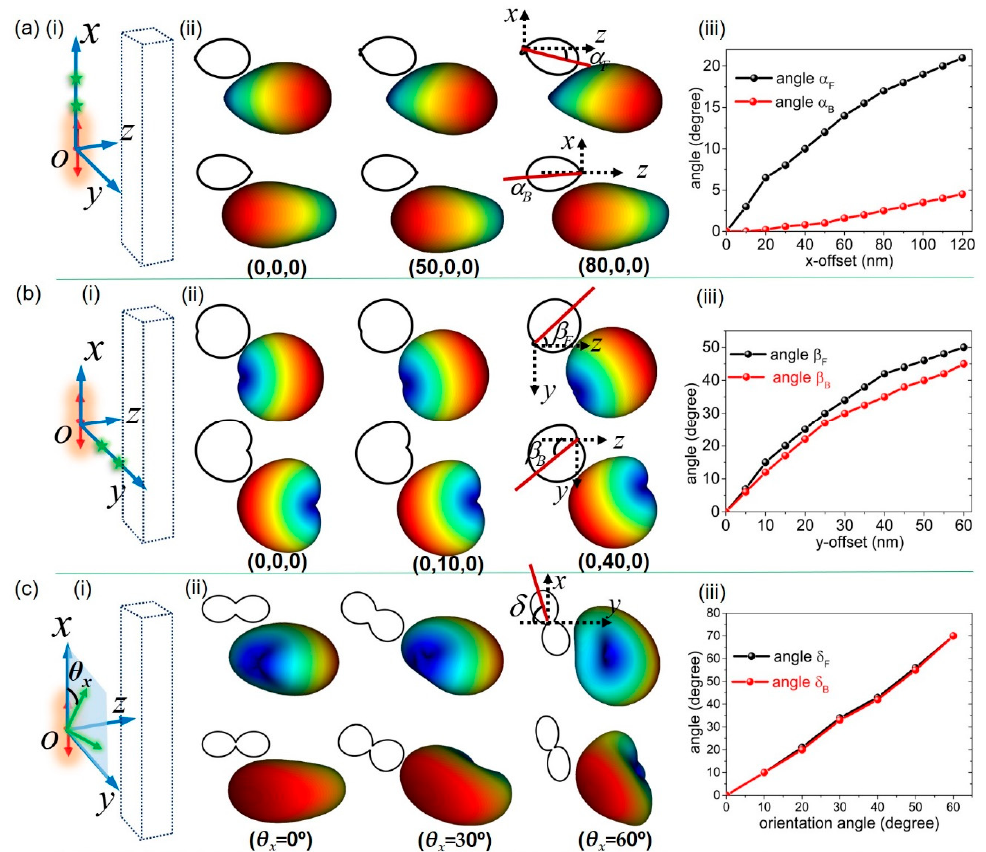
Figure 5. Far-field emission patterns dependencies on the configurations of the localized emitter and the nanoblock. ( a ) The source emitter has lateral displacement along x-axis. (i) sketch of the emitter-nanoblock configuration. The dipole emitter is denoted as a red arrow with initial position at the origin of the coordinates. Green star indicates the emitter at other offsetting positions. (ii) Side-views of far-field radiation patterns on the xoz plane and the top-left shows the corresponding cross-sections of the radiation patterns. The main lobe of the far-field emission shifts with increasing offset, with the maximal azimuthal angle denoted as α F and α B, respectively, for FW and BW emission. The bottom shows the coordinate positions of the source emitter. (iii) Dependence of the main lobe azimuthal angles on the offset values. ( b ) The source emitter has lateral displacement along y-axis (i). (ii) Side-views of far-field radiation patterns on the yoz plane and the corresponding cross-sections on the top-left. (iii) Dependence of the rotation angles on the offset values. ( c ) The source emitter has different orientation angles θ x , which are defined to be the angle between the dipole axis and x-axis (i). Perspectives of far-field radiation patterns and the cross-sections on the xoy plane on the top-left. (iii) Dependence of the rotation angles on the orientation angles.